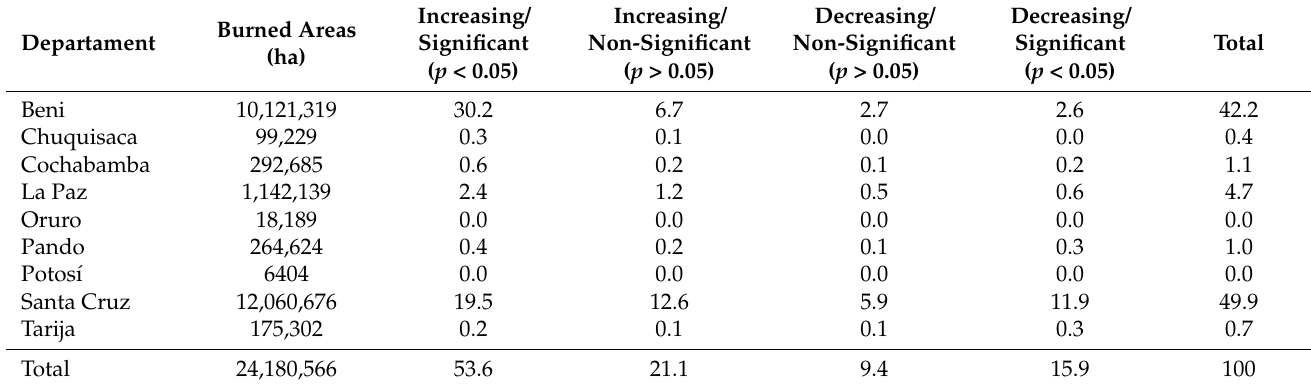
Table 1. Post-fire natural regeneration trends for the nine administrative departments of Bolivia, based on the Mann-Kendall test (increasing, decreasing) and statistically significance values ( p < 0.05, p > 0.05). The data are presented in percentages in relation to the total burned area in the period